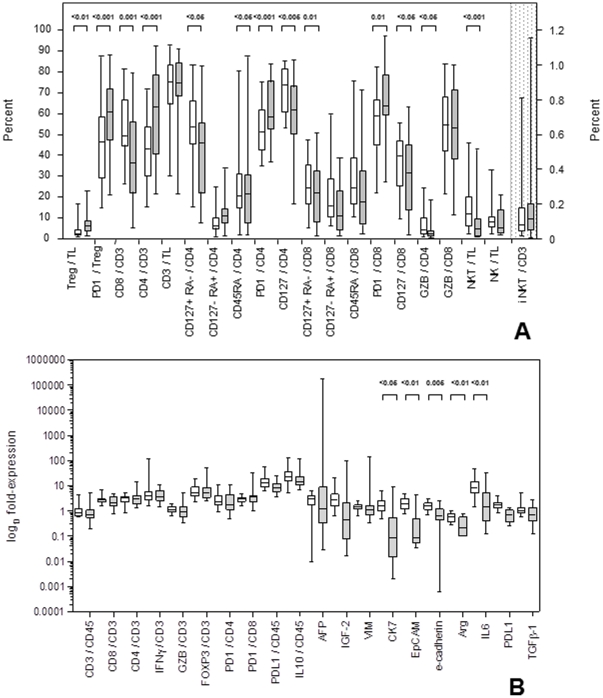
Differential distribution of infiltrating cell subsets and mRNAs between nontumorous and tumorous liver tissue samples.A: infiltrating cell subsets B: mRNAs; white bars: nontumorous and grey bars: tumorous liver tissue samples. Significance levels are shown on top of each panel. The right y axis of the upper panel refers to iNKT/CD3.